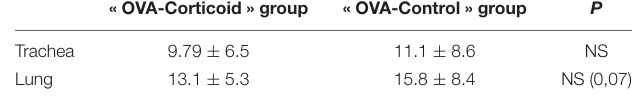
Paired t-test for comparison between groups.